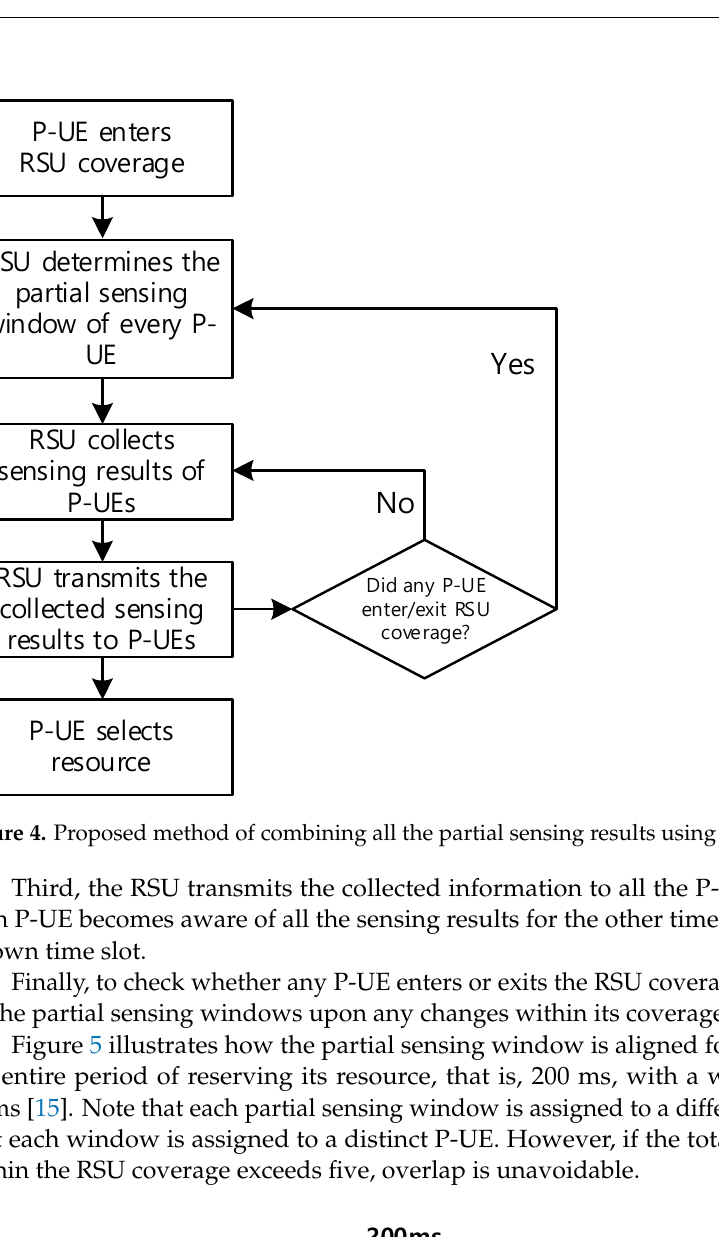
4 of 12 Figure 2. Partial sensing window and selection window. With partial sensing, power consumption can be reduced to approximately 1/5 (=40 ms/200 ms) compared to the case of sensing the resources for the entire 200 ms observation period. It can also prevent collisions, unlike in random selection. However, because sens- ing is performed only for a 40 ms partial window, selectable resources are also limited only for the corresponding time interval. Consequently, the throughput is reduced to nearly 1/5 (=40 ms/200 ms). We claim that, if several P-UEs can share their sensing results with each other, the throughput may be substantially improved. In the next section, we present a method for combining all the partial sensing results. 3. How to Combine All the Partial Sensing Results To describe the novel procedure of combining all the partial sensing results, we first introduce an additional UE, denoted RSU, in the region of mode-2 sidelink communica- tions of interest. The RSU is a hardware entity that is generally defined as a terminal to assist vehicular communications in out-of-coverage areas [14]. Figure 3 illustrates a mode-2 sidelink signal environment, including several P-UEs within the coverage of an RSU. RSU coverageRSU P-UE#3P-UE#2 P-UE#1 P-UE#5 P-UE#4 Figure 3. A mode-2 sidelink signal environment consisting of an RSU and P-UEs.